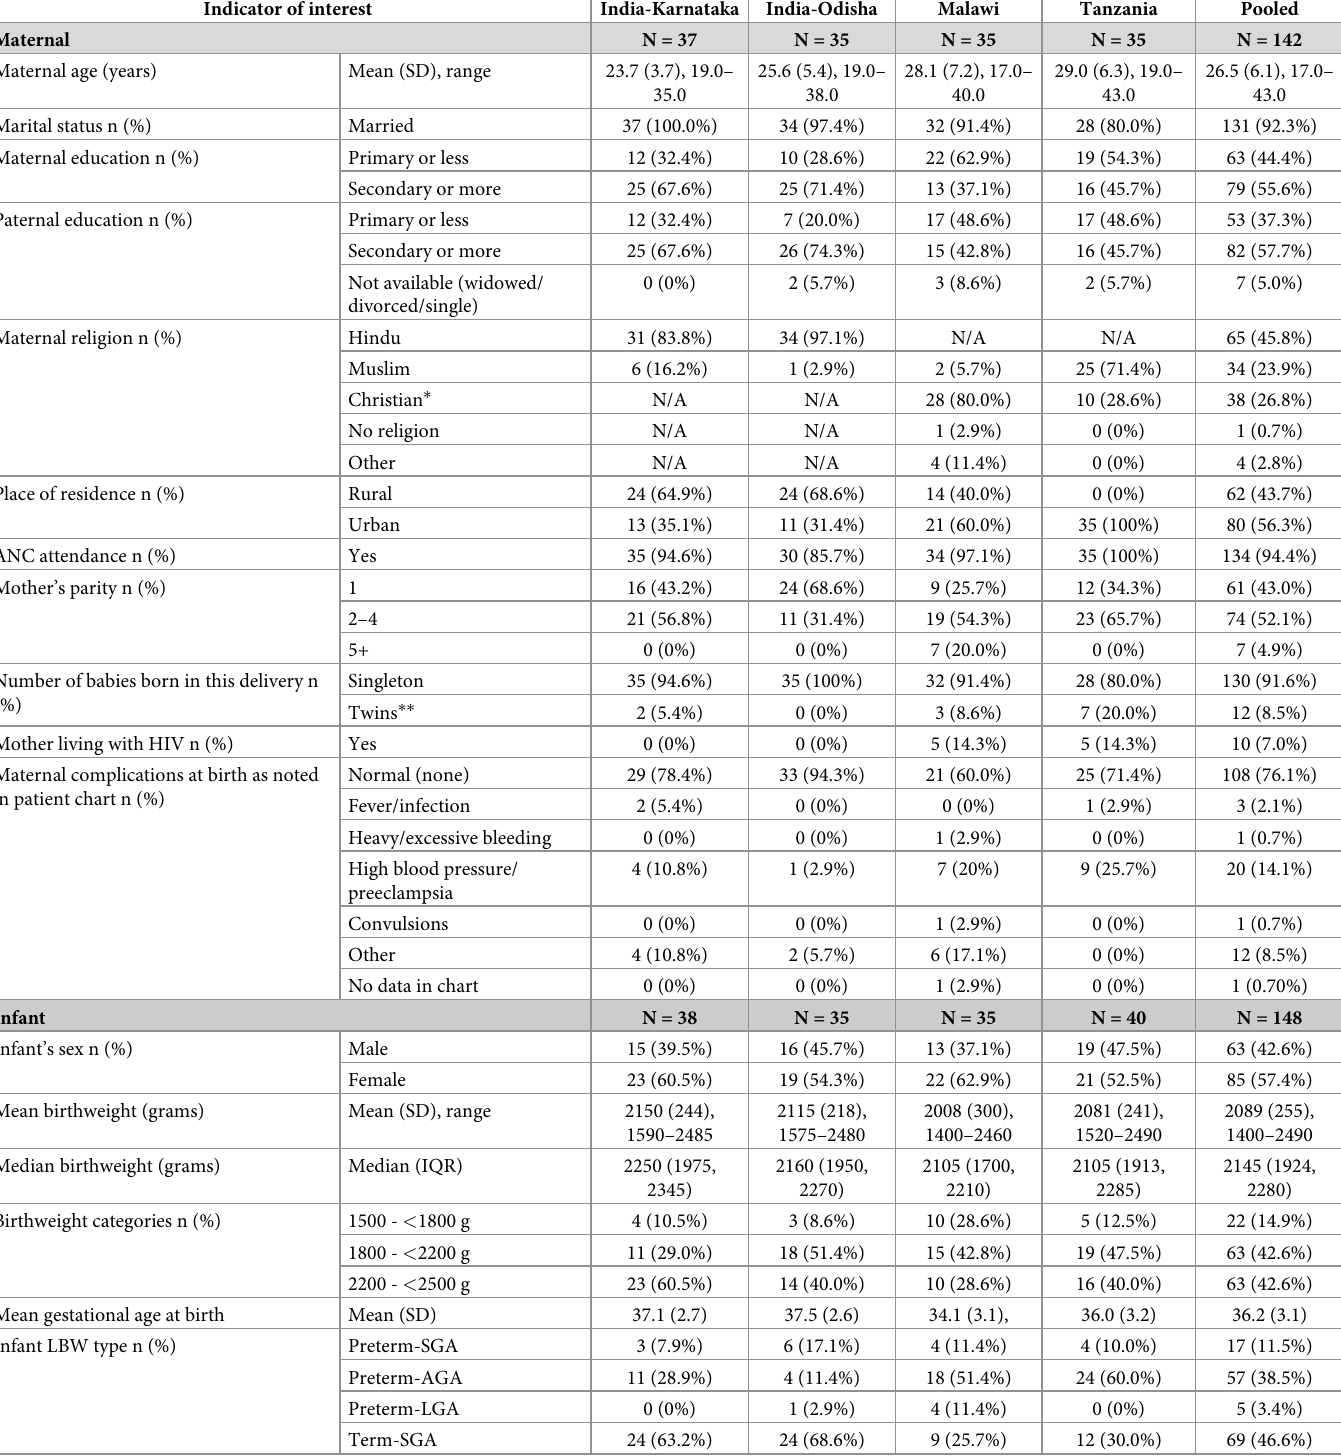
Table 3. Maternal and infant characteristics in a cohort of 148 moderately low birthweight infants in 12 facilities in India, Malawi, and Tanzania. Indicator of